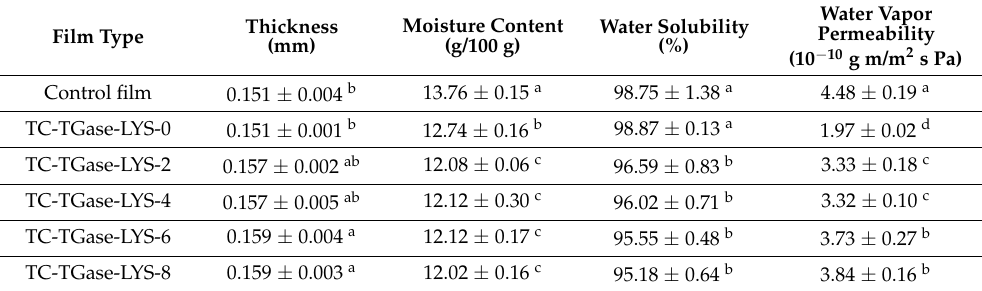
Table 2. Thickness, moisture content, water solubility and water vapor permeability of transglutami- nase (TGase) cross-linked tilapia collagen (TC) films incorporated with lysozyme